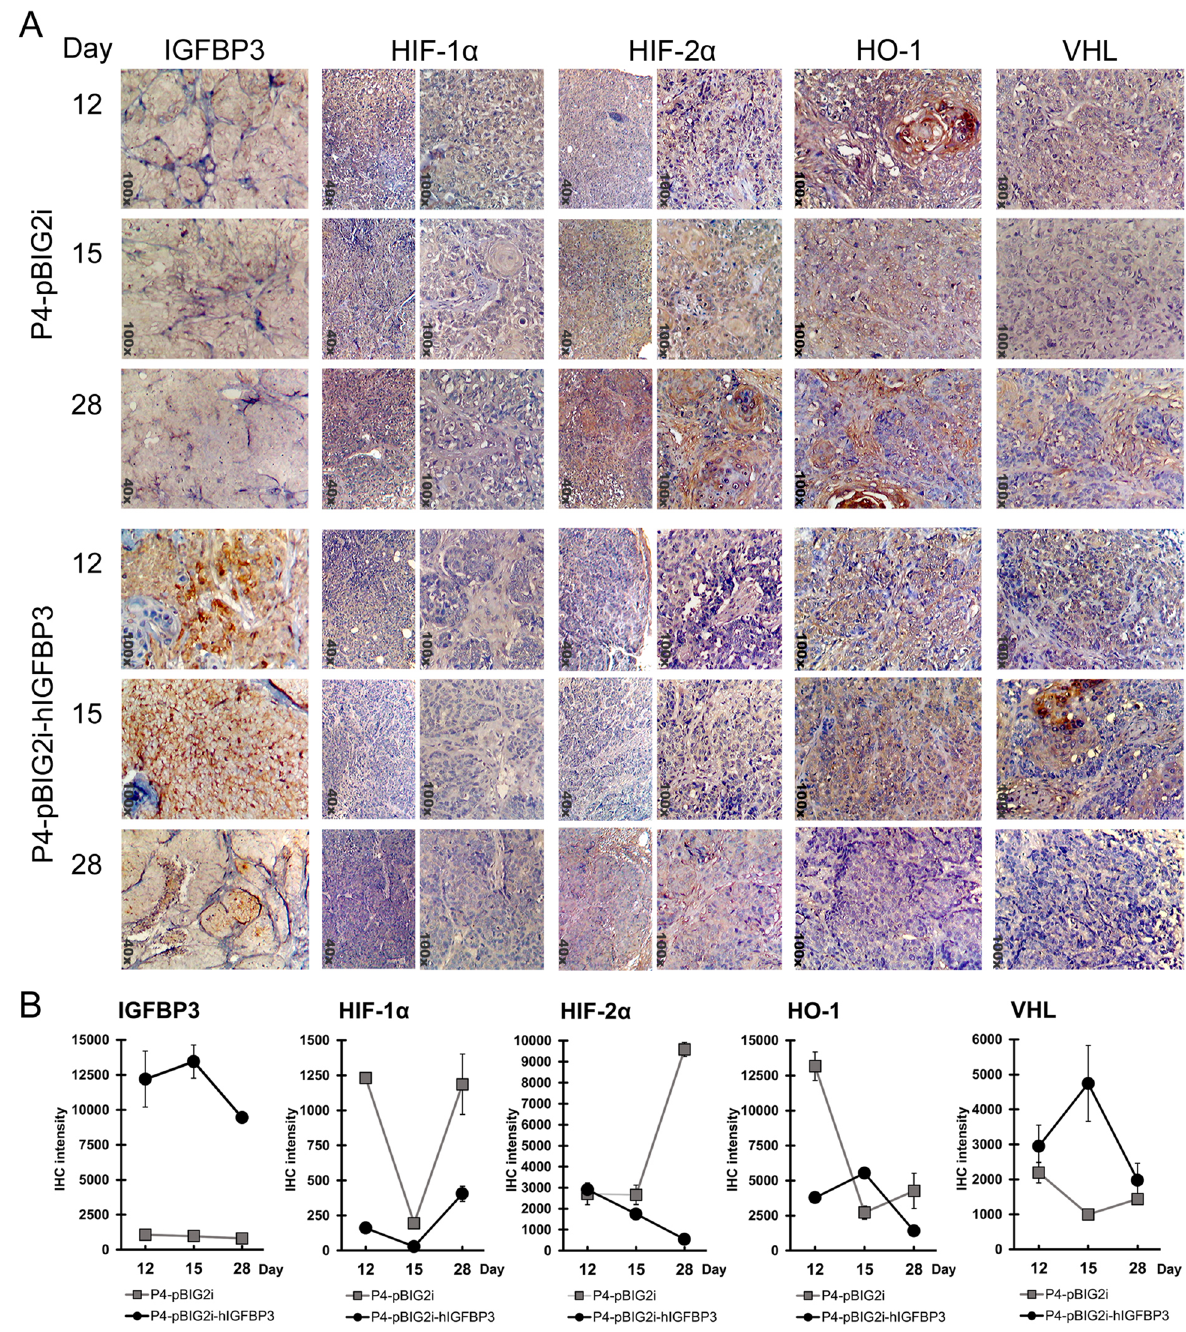
Figure 2. Immunohistochemistry staining of xenografts on 12, 15, and 28 d after the tumor implantation. ( A ) Heterotransplantation tumors P4-pBIG2i and P4-pBIG2i-hIGFBP3 at 12, 15, and 28 d post-tumor implantation on IGFBP3 (100 ×), HIF-1α (40 × and 100 ×), HIF-2α (40 × and 100 ×), HO-1 (100 ×), and VHL (100 ×). P4-pBIG2i xenograft showed no IGFBP3 expressions, while P4-pBIG2i-hIGFBP3 showed a strong IGFBP3 expression after adding doxycycline (started on d 8). HIF-2α increased over time in P4-pBIG2i xenograft, but it only accumulated after 28 d in P4-pBIG2i-hIGFBP3 xenograft. Xenograft tumors without IGFBP3 expressed HIF-2α majorly, especially under a prolonged tumor growth in hypoxic environments. ( B ) Quantitative analysis of immunohistochemical staining. Images of IHC were taken by Motic Image Plus 3.0 software. The signals of IHC were quantified and analyzed by ImageJ 1.53 k software. Excel 2016 was used to generate charts. Photoshop CS2 version 9 was used to assemble the